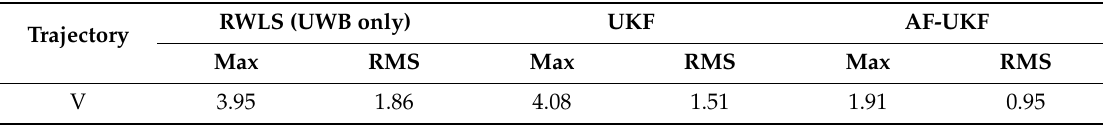
Table 5. Statistics of Euclidean Distance Errors in trajectory V